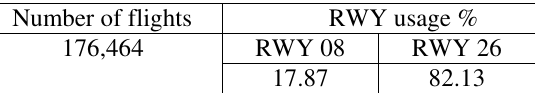
Table 1. Runway use for overall traffic in 2008